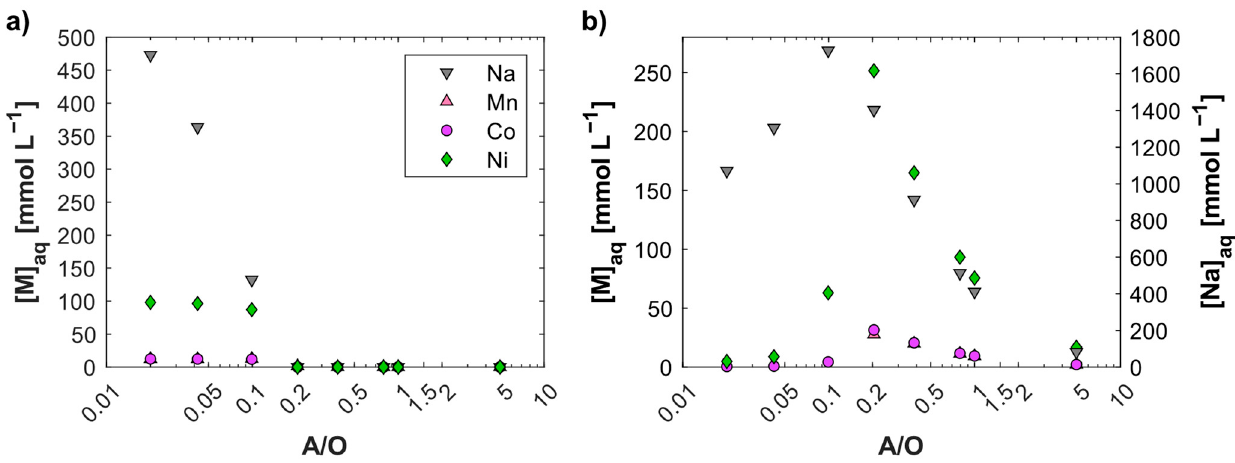
Figure 10. Equilibrium concentrations of metals in ( a ) the organic phase and ( b ) the aqueous phase in stripping of Ni, Co, Mn, and Na from 0.8 M NCM-D2EHPA with 2 M H 2 SO 4 . T = 25 ± 1 °C; t eq = 15 min. [Ni] 0,org = 93.1 mmol L − 1 , [Co] 0,org = 11.7 mmol L − 1 , [Mn] 0,org = 11.5 mmol L − 1 , [Na] 0,org = 529 mmol L − 1 .